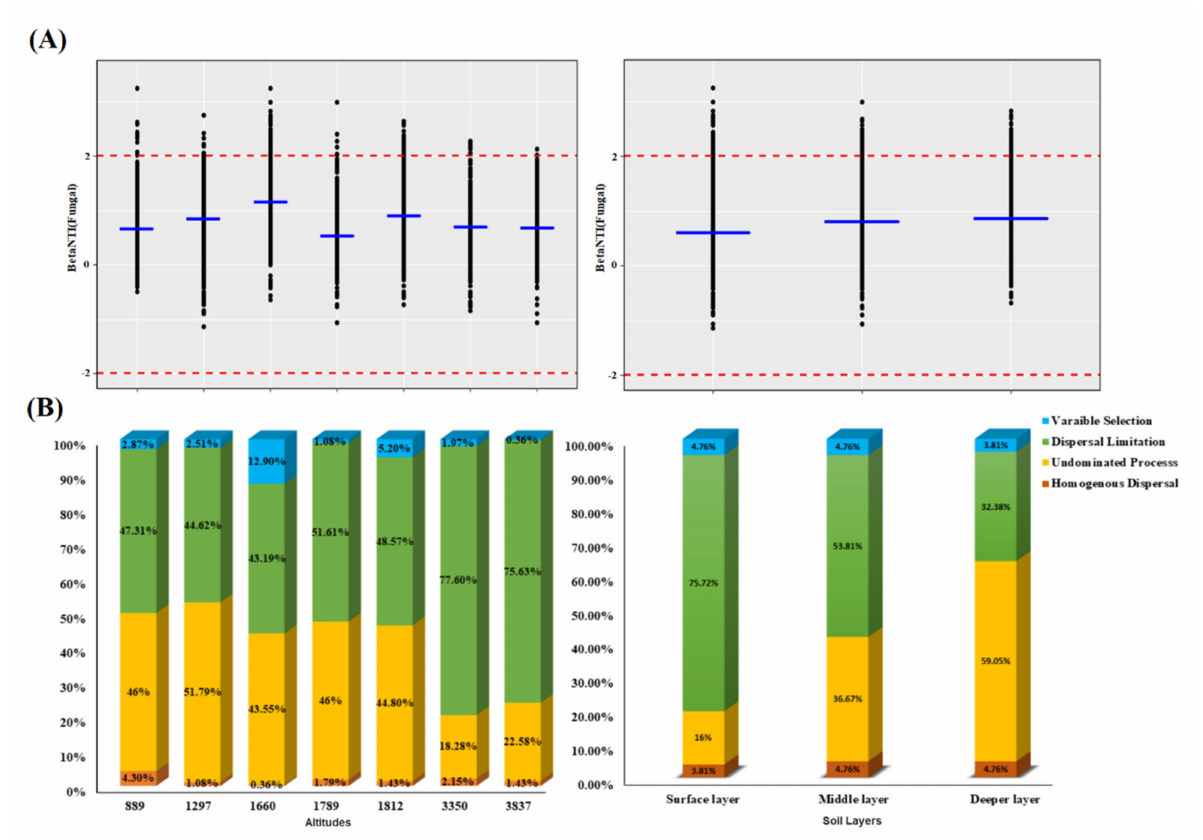
Figure 5. ( A ) Scatter plot of β NTI across spatial scales of Tibetan soil. Blue line indicating the median values of each sampling location. ( B ) Quantitative analysis of relative importance of each assembly process that govern the fungal community